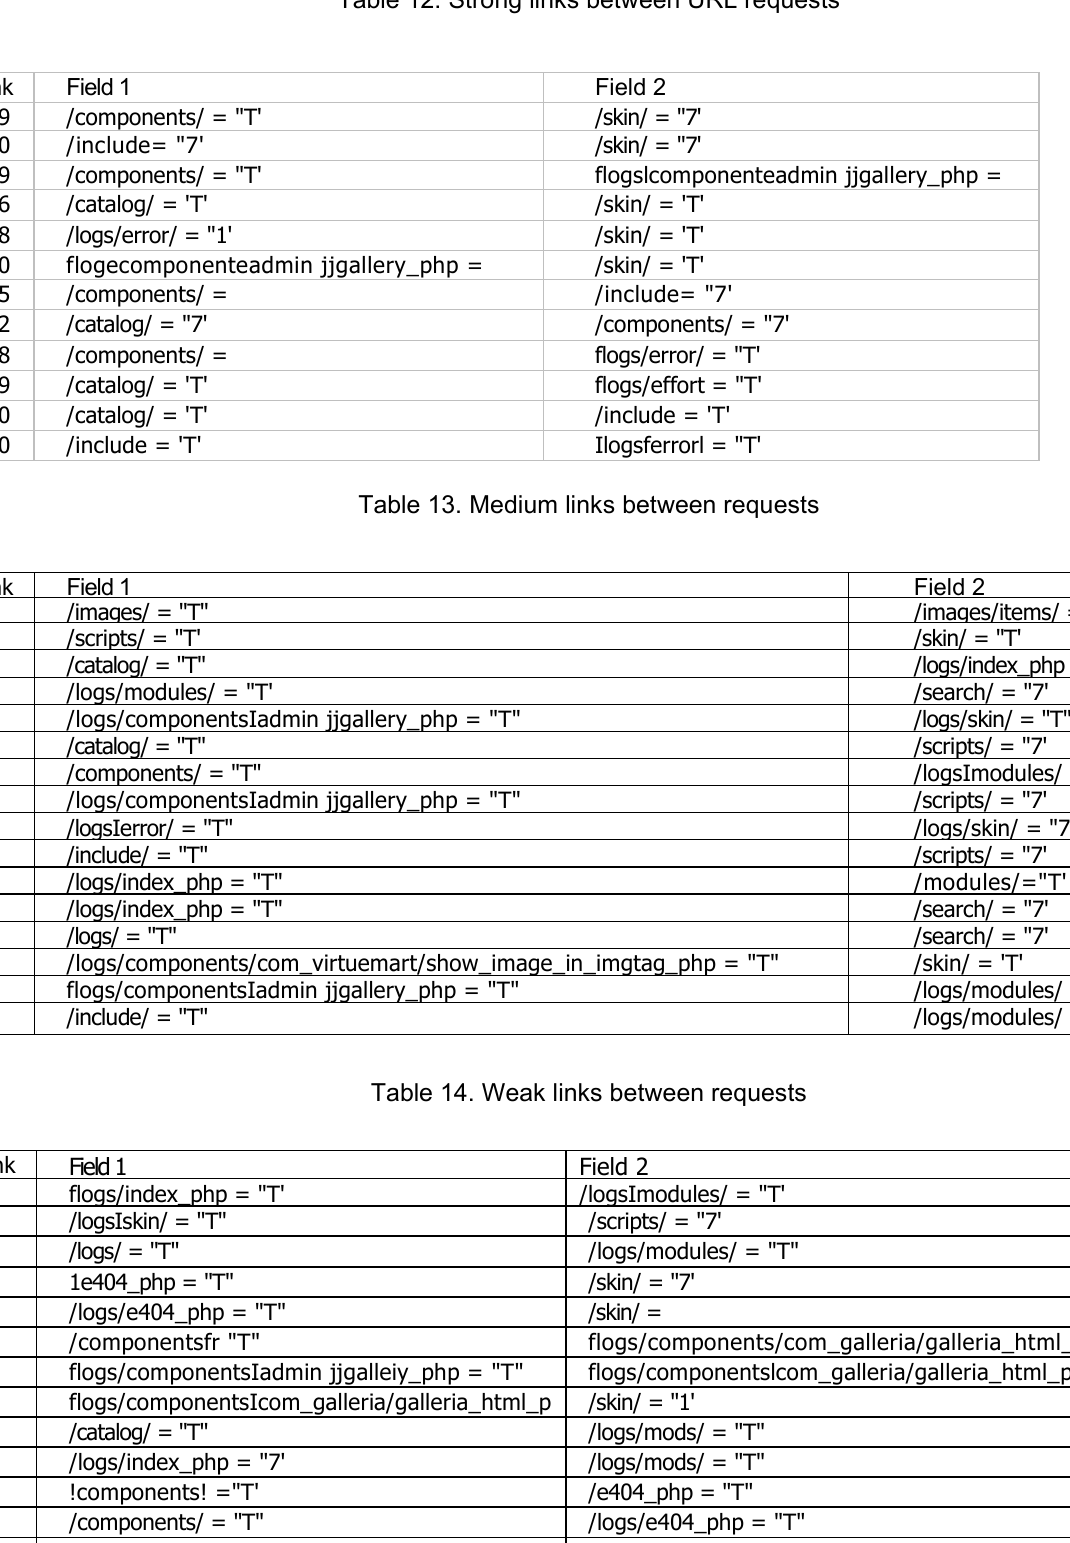
Table 12. Strong links between URL requests